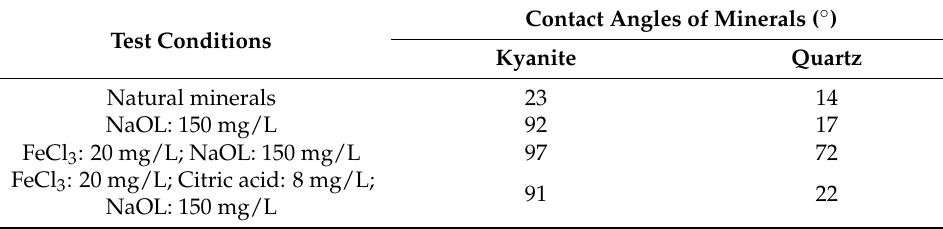
Table 3. Contact angles of mineral samples under different test